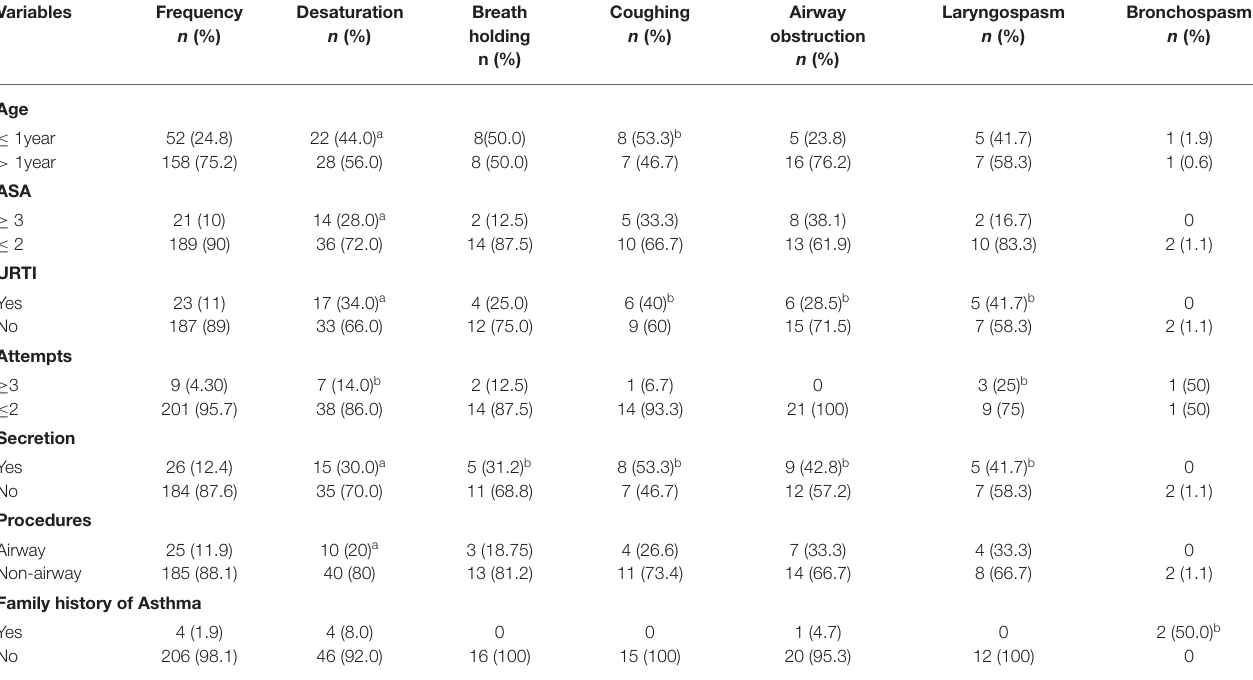
TABLE 3 | Pearson Chi-squared and Fisher-exact tests; factors associated with perioperative respiratory adverse events among pediatric surgical patients underwent surgery under general anesthesia at UoGCSH and TGSH, Northwest Ethiopia; March 1–May 30, 2020 ( N = 210).